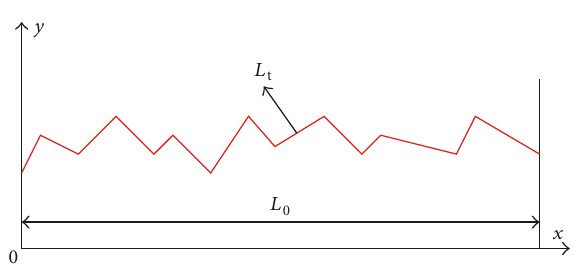
Figure 6: The illustration of sound propagation pathway 𝐿 t versus the thickness 𝐿 0 of the